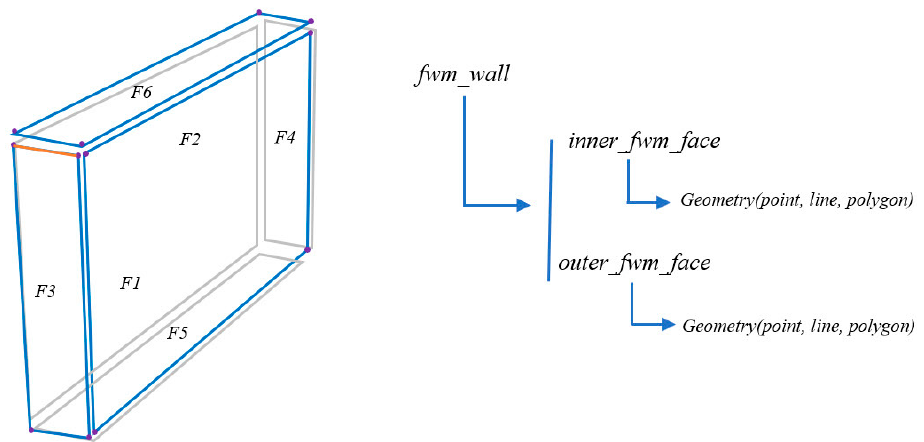
Figure 7. ( a ). ifcWall representation with faces, faces’ lines, and points ; ( b ). the proposed fwm_wall and fwm_face object-oriented data model.